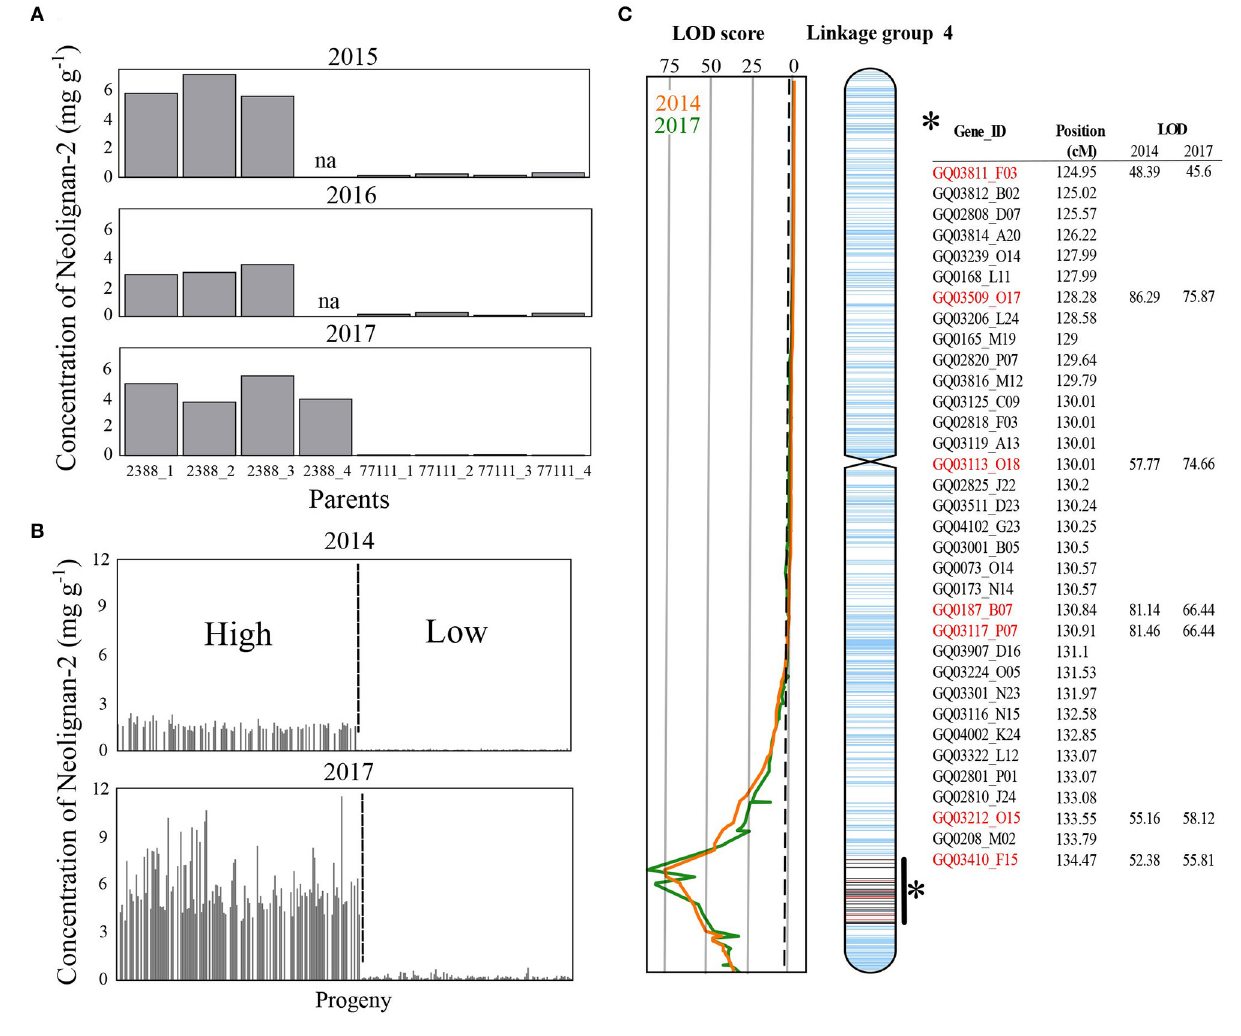
FIGURE 2 | Metabolite concentrations and QTL mapping for neolignan-2. Concentrations of neolignan-2 obtained (A) from grafted material (3–4 ramets) corresponding to both parents ( ♀ 77111, ♂ 2388) sampled in August 2015, 2016, and 2017, and (B) from 164 and 202 siblings sampled in August 2014 and 2017, respectively. (C) Linkage map of the white spruce progeny showing location of the putative QTLs with LOD score for neolignan-2 in 2014 (orange line) and 2017 (green line). The peak LOD score reached 75.87 and 86.29 in 2014 and 2017, respectively. The vertical dotted line indicates the threshold for significant linkages of the LOD scores (i.e., 3.1). Ticks on the chromosome represent mapped genes according to Pavy et al. (2017). Within the QTL interval, red and black ticks are genes for which markers were detected for ♂ 2388 and ♀ 77111,